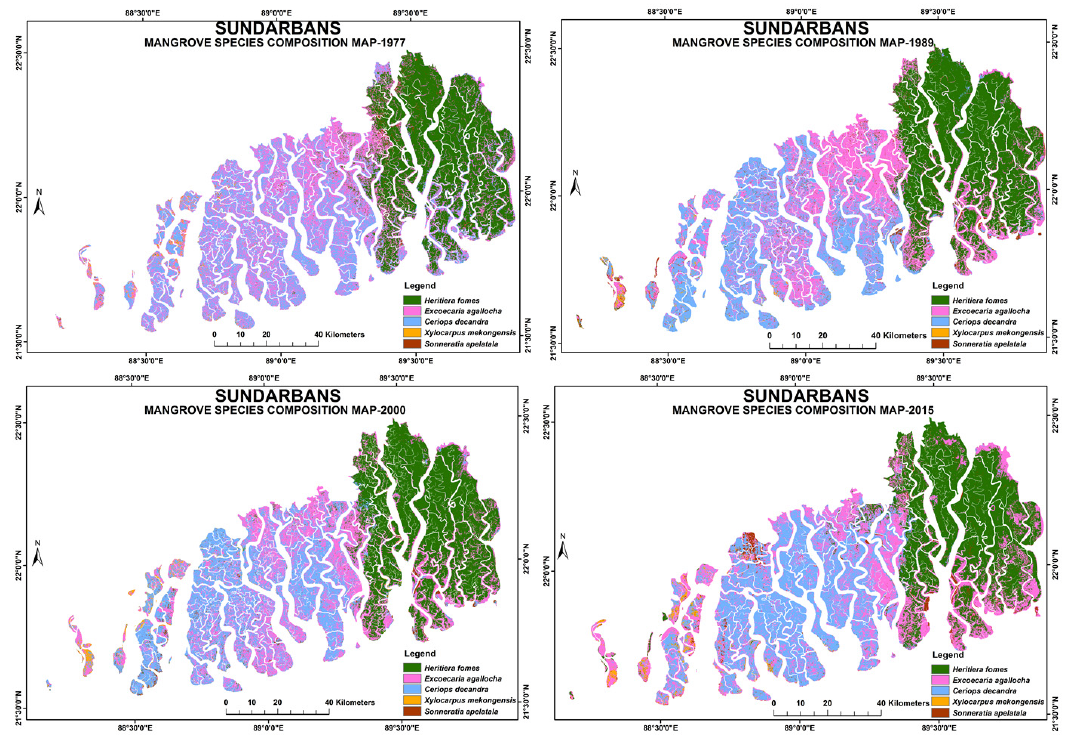
Figure 4. Mangrove species composition map of the Sundarbans mangrove forest.